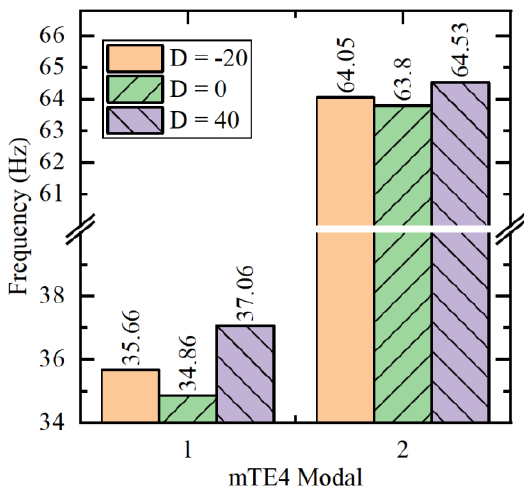
Figure 11. Experimental modal analysis of mTE4 at different actuation inputs.